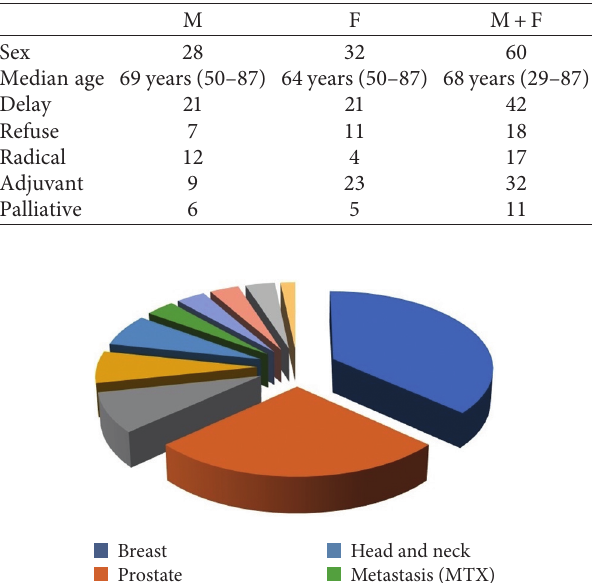
Table 1: Description of patients’ characteristics.